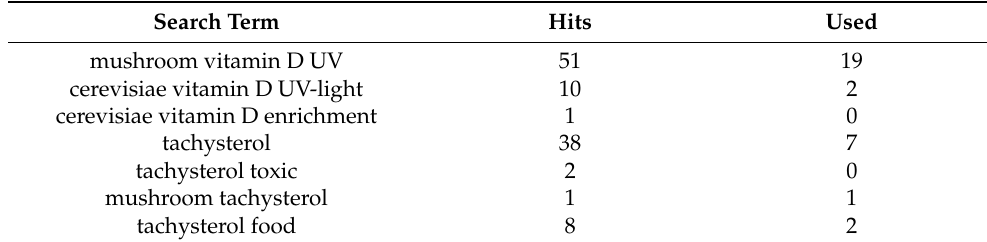
Table 6. Used search terms for the initial literature search, also showing the number of hits for each search term, and the number of used literature sources finally